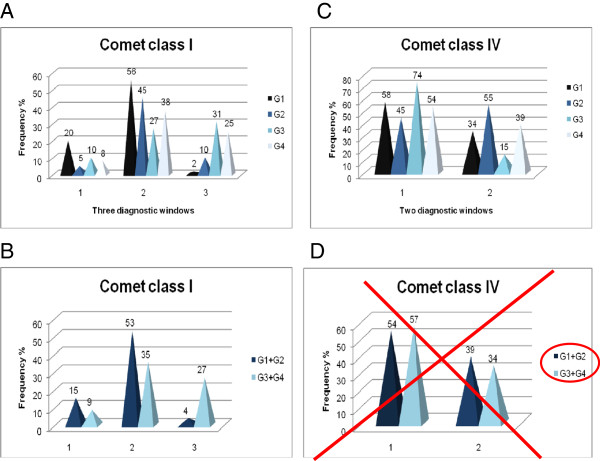
Diagrams estimating a predictive power of the comet-fractions (comet class I and IV), further utilised in the construction of diagnostic windows for breast cancer risk assessment (A, B and C); according to the diagnosis, the recruited patients are grouped as follows: pre-menopausal women with benign alterations in breast tissue (G1); post-menopausal women with benign alterations in breast tissue (G2); invasive lobular & ductal carcinomas in pre-menopausal women (G3); invasive lobular & ductal carcinomas in post-menopausal women (G4); data taken from [36]. Obviously, the diagnostic windows with the comet class IV patterns can be effective only when the hormonal status is considered as one of the selection parameters for subgrouping the patients and concomitant utilisation of the analytical approach proposed by this study.